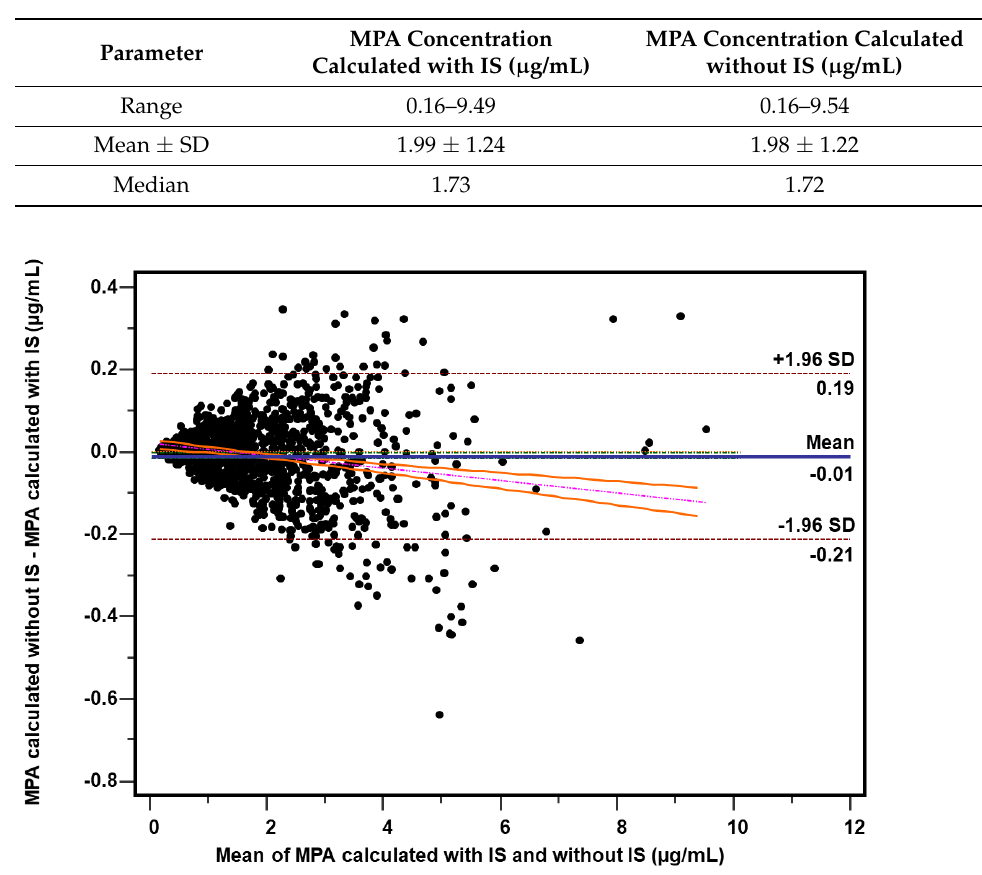
Figure 2. Comparison of calculation methods made on a total of 1187 samples from heart transplant patients. Bland–Altman analysis—plot of difference against mean for MPA concentrations ( µ g/mL) obtained without using IS and with using IS presented as absolute bias. Horizontal lines represent bias (solid: mean, dashed: ± 1.96 SD), whereas the regression line of differences (with its 95% CI) is indicated by dotted line.